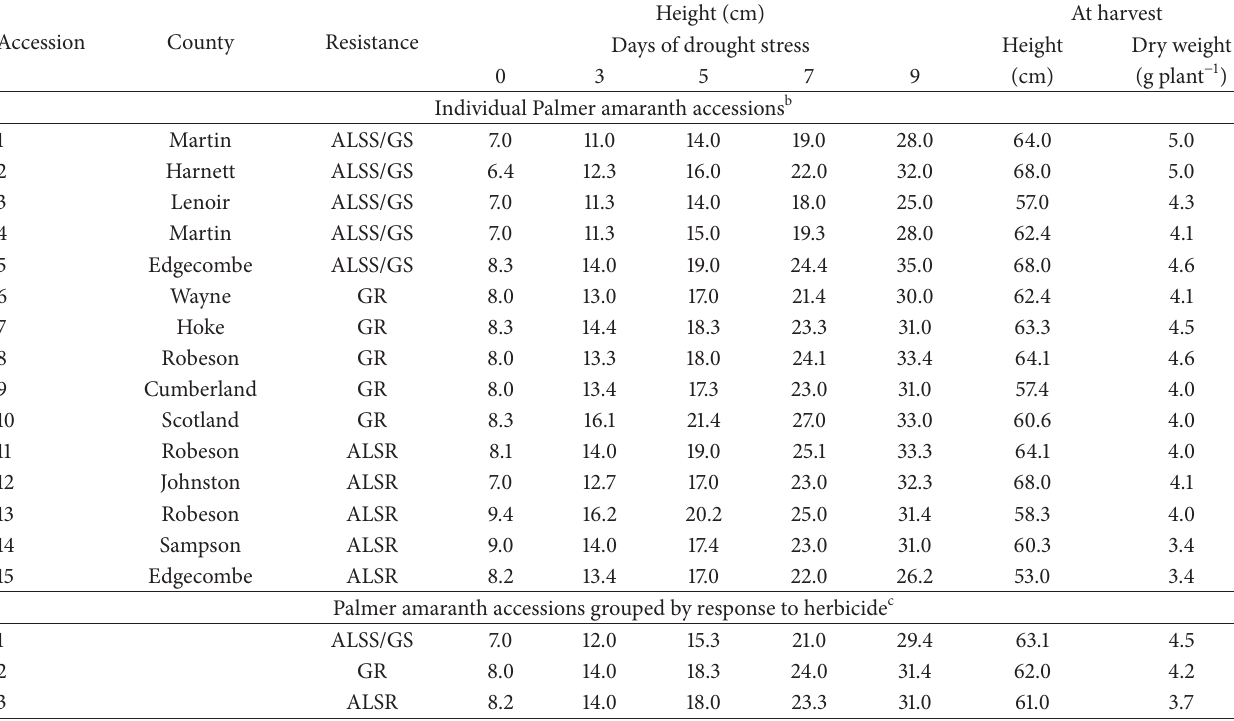
Table 1: Height and dry weight of Palmer amaranth controls a .